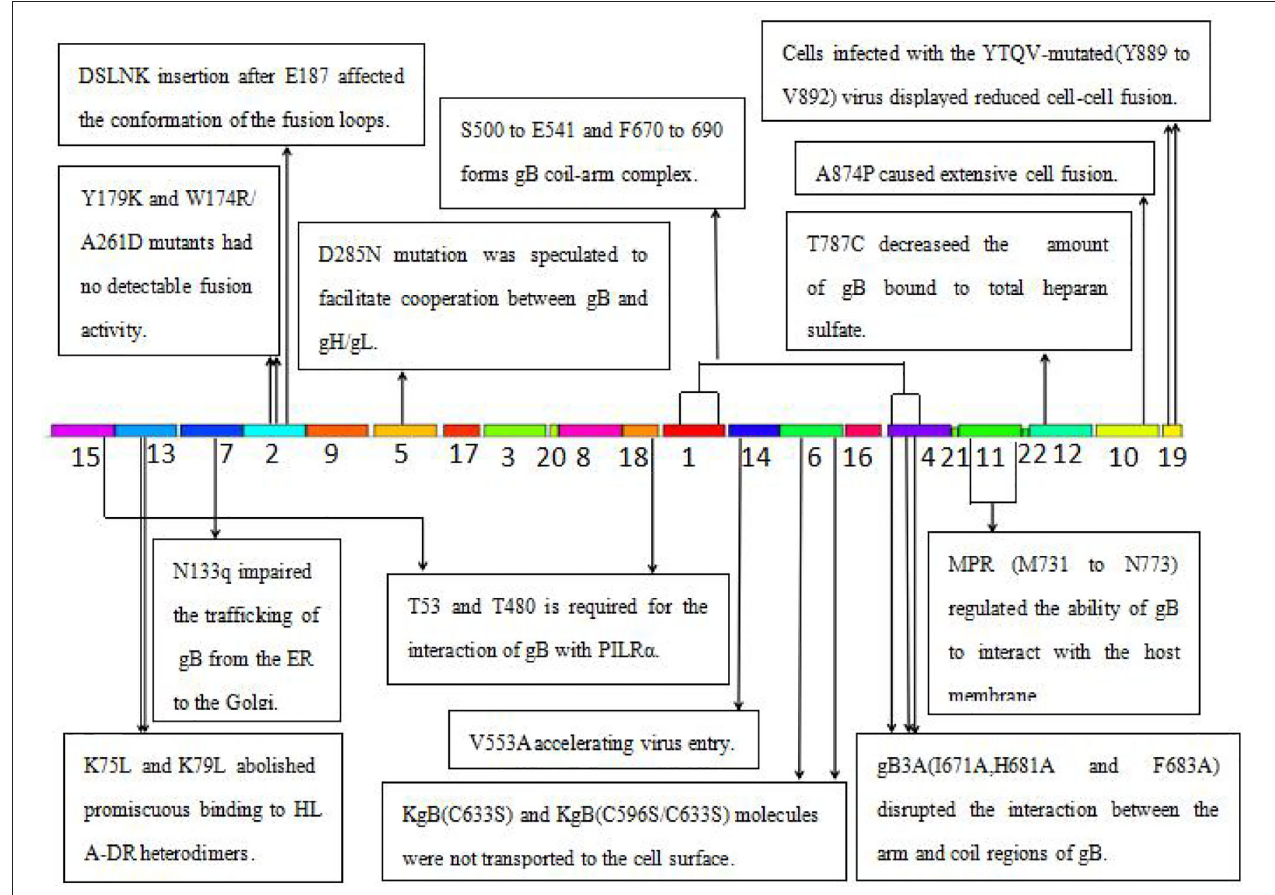
FIGURE 5 | The function of the identified 22 motifs of gB of HSV. MPR, membrane-proximal region; PILR, the paired immunoglobulin-like type 2 receptor; HLA-DR, human leukocytic antigen DR; ER, endoplasmic